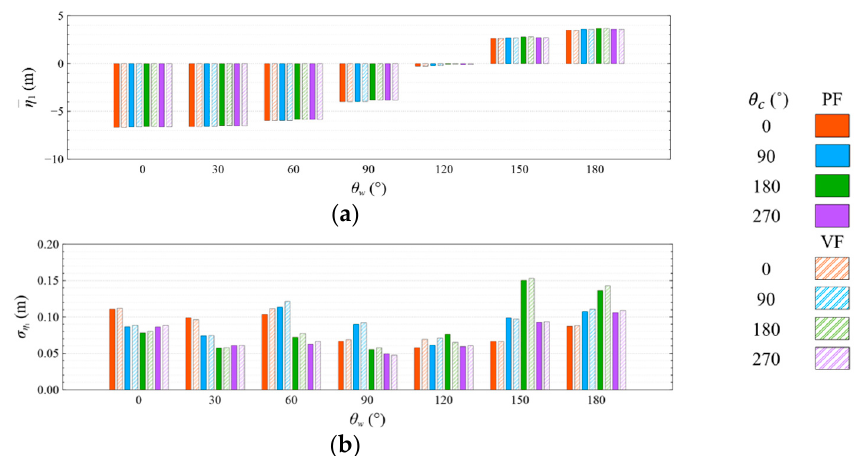
Figure 14. Comparison of ( a ) means and ( b ) standard deviations of platform surge motion under CW condition.